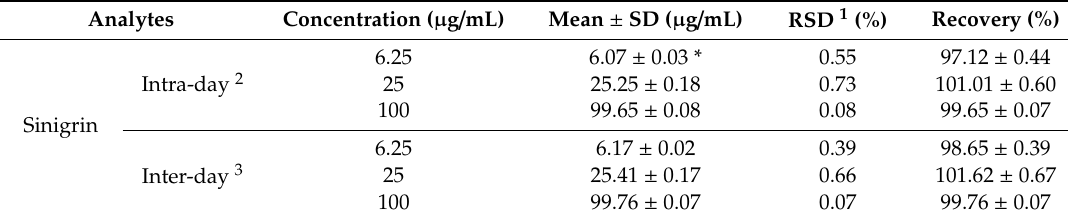
Table 5. Precision and accuracy of sinigrin analysis.